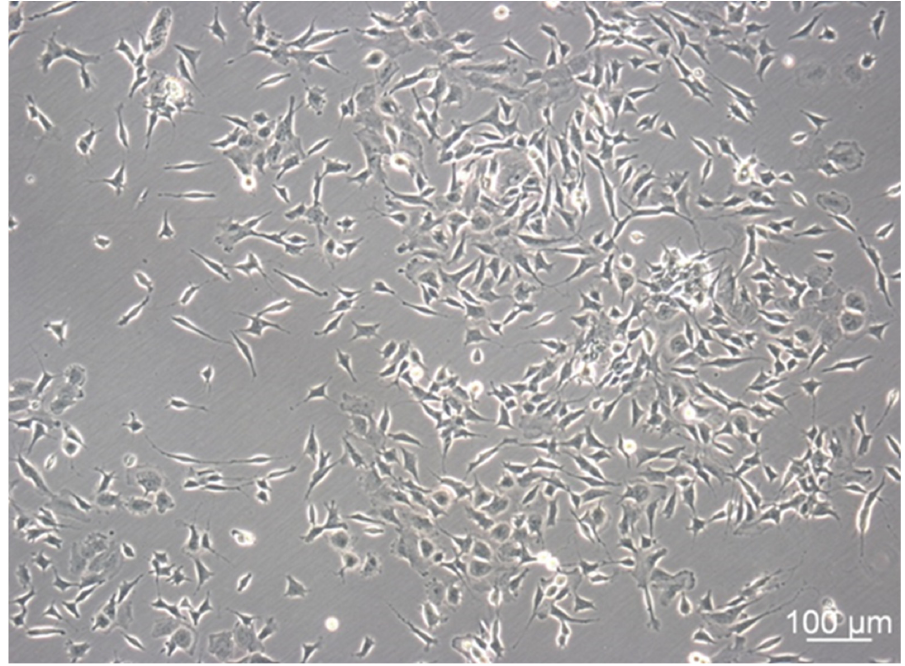
Figure 2. Morphology of SH-SY5Y cells after incubation of 120 h under standard cultivation condi- tions and an initial cell count of 5 × 10 4 cells/cm 2 . 100 ×,